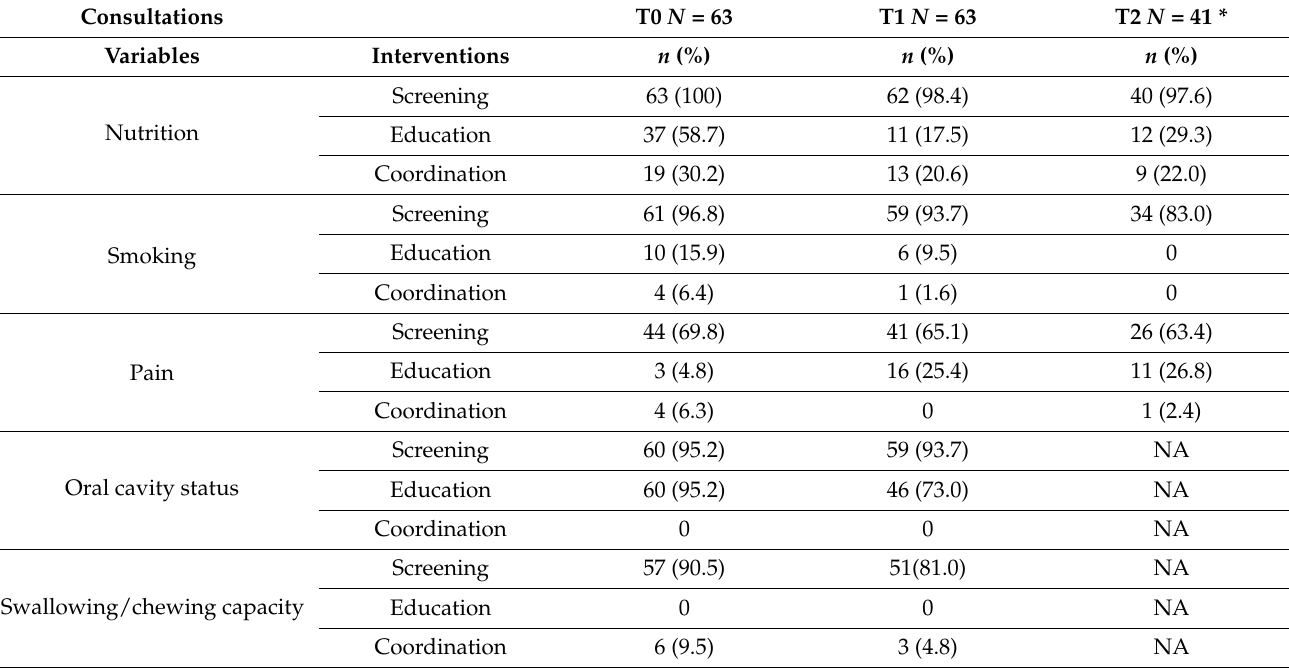
Table 2. Number of nursing interventions provided, according to the intervention domain during the consultations at three different times during radiotherapy